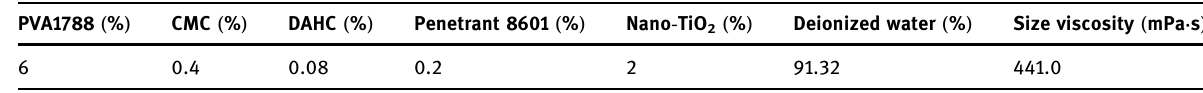
Table 2: PVA size formula for coating harness